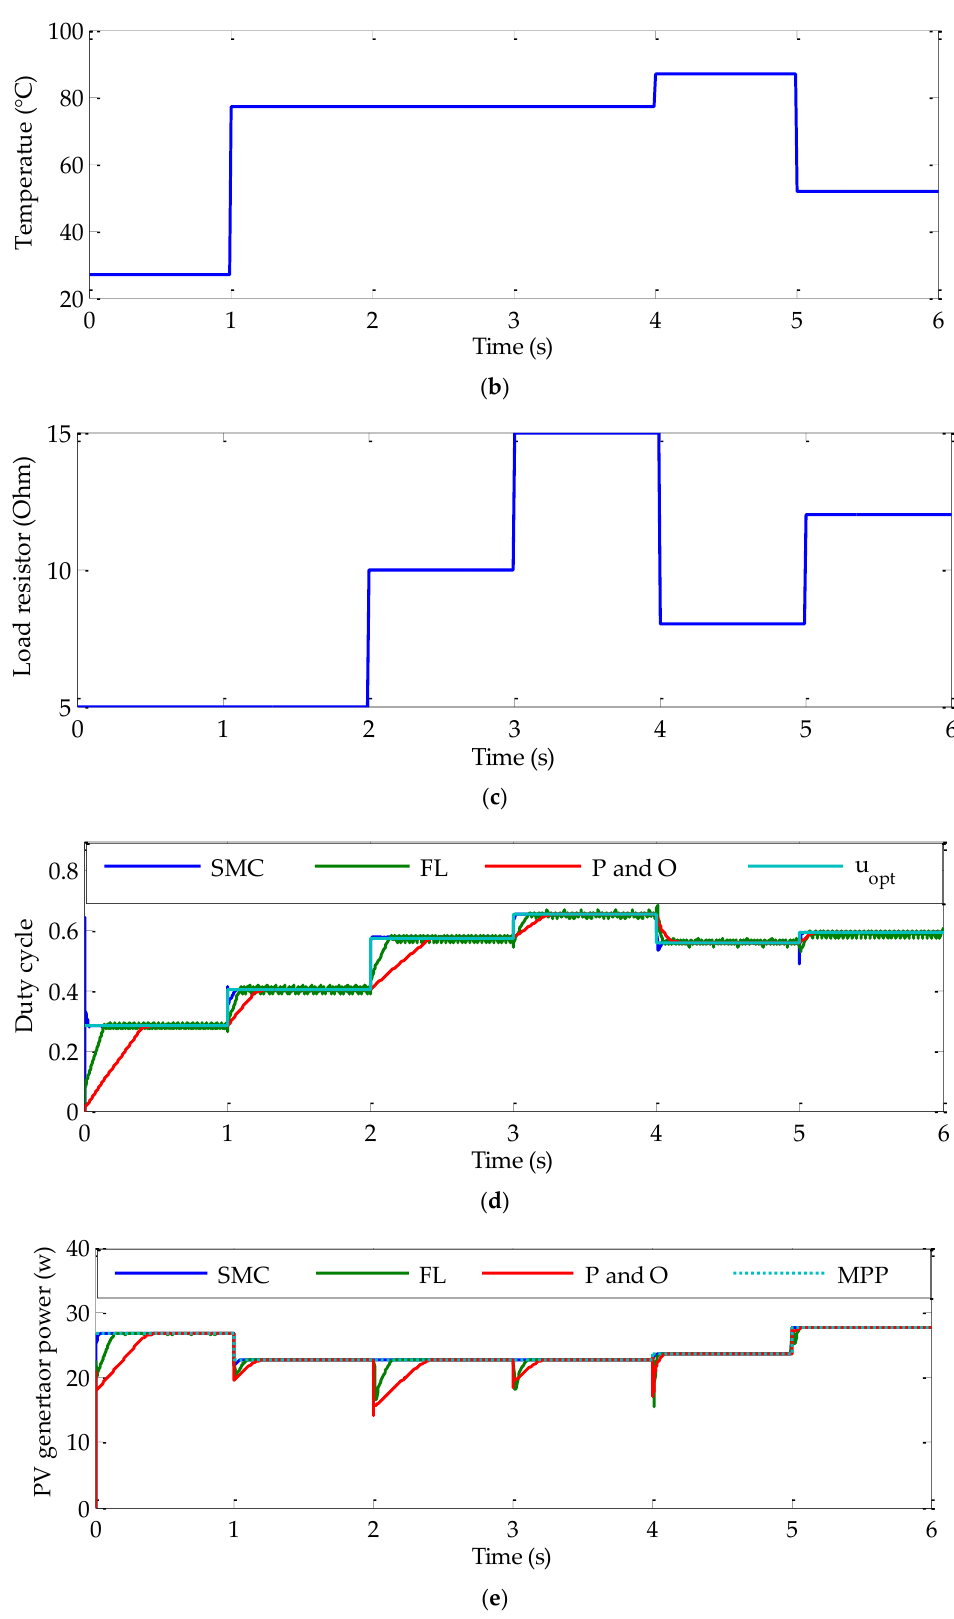
Figure 9. Simulation results given by the three MPPT algorithms under various operating conditions: ( a ) Radiation trajectory, ( b ) Temperature trajectory, ( c ) Load resistor trajectory, ( d ) Duty cycles, and ( e ) PV generator